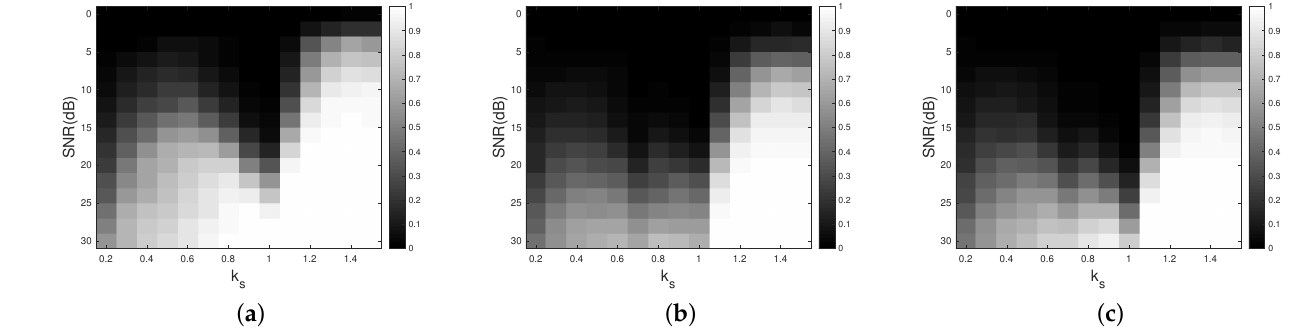
Figure 8. Detection rate of Tomo-ANM and SL1MMER under different SNRs and normalized distances. ( a ) Tomo-ANM. ( b ) SL1MMER 20 . ( c ) SL1MMER 30 . Time Consumption : The time consumption of ANM and SL1MMER was shown and analyzed. For convenience, Tomo-ANM-SDP denotes ANM realization by the SDPT3 tool, while Tomo-ANM-IVDST does so by IVDST. The L 1 norm minimization of SL1MMER was implemented by the iterative shrinkage-thresholding (IST) algorithm. To assess the computational efficiency of different methods, we recorded statistics on the average running time of 200 independent points under different SNRs. Only the inversion process was timed, excluding the model selection and amplitude correction steps. The simulation was performed on MATLAB 2019b on a computer equipped with an Intel Core i7 CPU @ 2.60 GHz. The results are displayed in Figure 9. There is little difference in the time of each algorithm under different SNRs, so the average time is used for time comparison below. It can be seen that the ANM algorithm implemented by SDPT3 takes an average of 0.49 s, which is the longest time. The running time of the SL1MMER algorithm increases from 0.04 to 0.24 s with the increase in grid density from 5 M to 30 M. There is a sudden increase when the grid density reaches 15 times. The ANM algorithm implemented by IVDST takes an average of 0.02 s, which is the shortest time and even slightly faster than the SL1MMER 5 algorithm, which takes 0.04 s on average. It should be noted that the computational efficiency of Tomo-ANM-IVDST is related to parameter settings, which we discuss in Section 5.3. The computational complexity is highly related to the full data size. According to [24], the overall computational complexity of SDP is O ( N 3.5 ) using the advanced solver SDPT3, where N represents the size of the full data, while the computational complexity of IVDST is only O ( N 2 ) . As shown in Figure 9, the computational efficiency improvement caused by an order of 1.5 in computational complexity reduction is considerable.